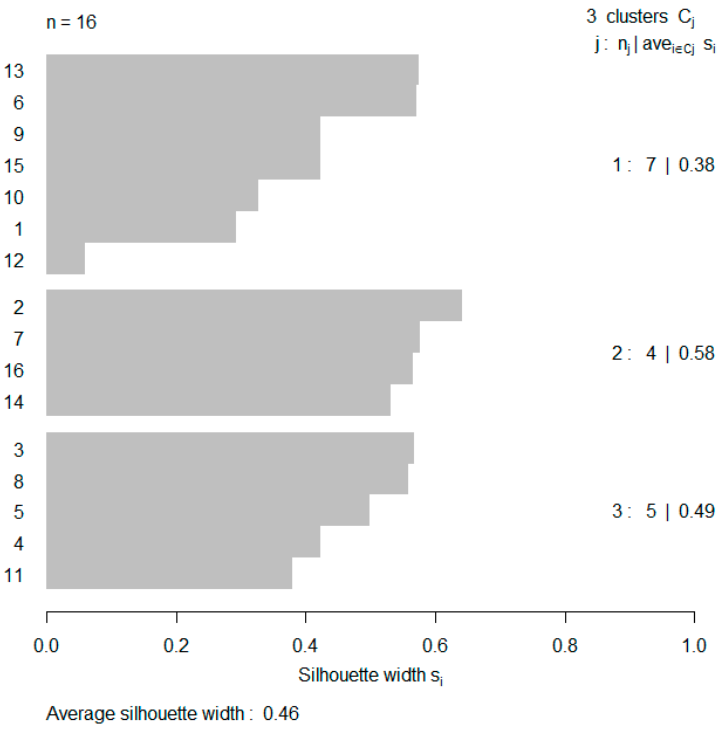
Figure 3. Silhouette analysis for time scale 8.